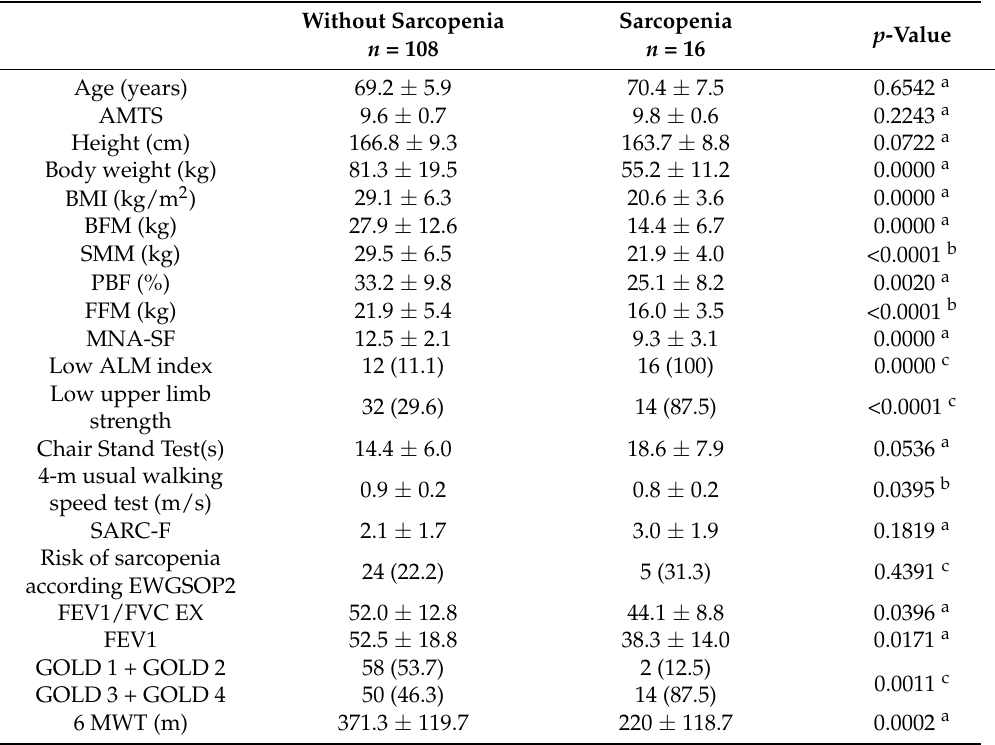
Table 2. Characteristics of subgroups with and without sarcopenia according to the EWGSOP2